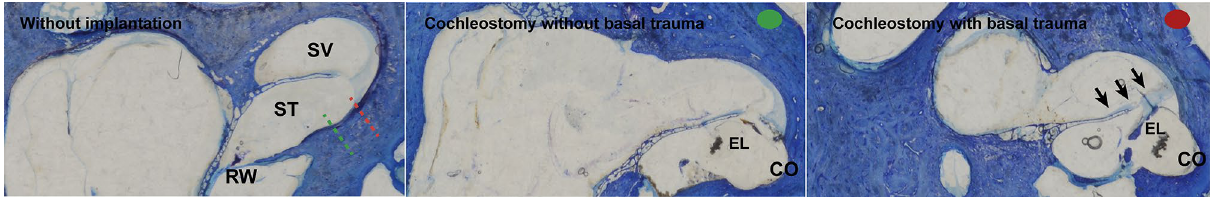
Figure 5. Histological modiolar plane sections. On the left a non-implanted basal turn of the cochlea. The green and red dotted lines depict angles of cochleostomy site of respectively the middle and right image. Green dotted line represents an antero-inferiorly placed cochleostomy, the red dotted line represents slight displacement of cochleostomy to anterior. In middle image, corresponding to the green line, no basal trauma is observed. In right image, corresponding to the red line, basal trauma is observed: displacement of stria vascularis, basilar membrane and osseous spiral lamina resulting in a crushed scala media compartment. RW round window, ST scala tympani, SV scala